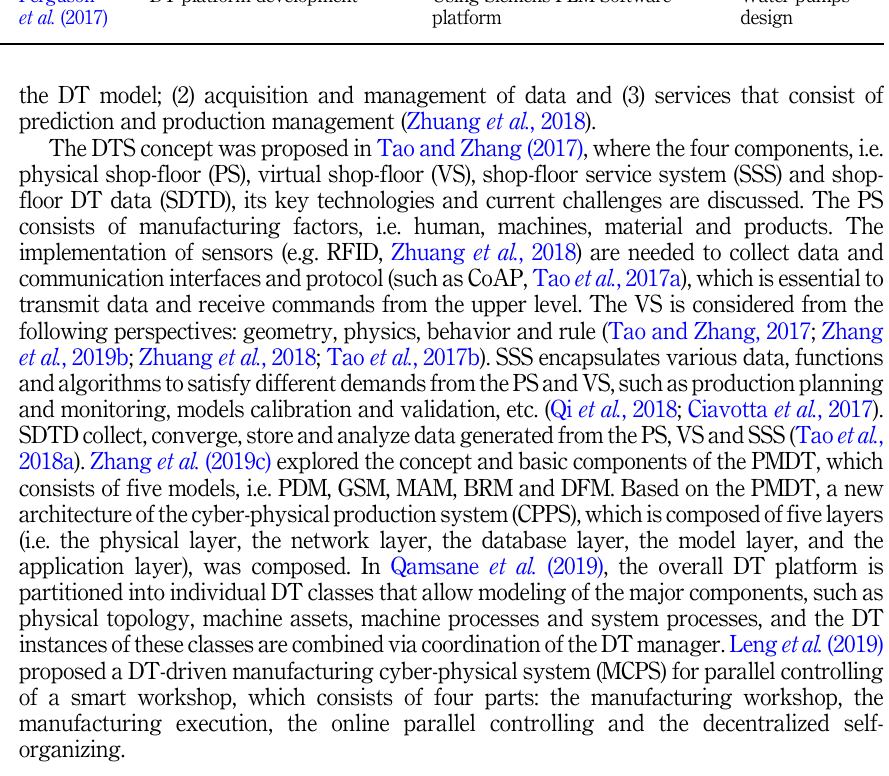
Table 3. Survey of DT references for the design